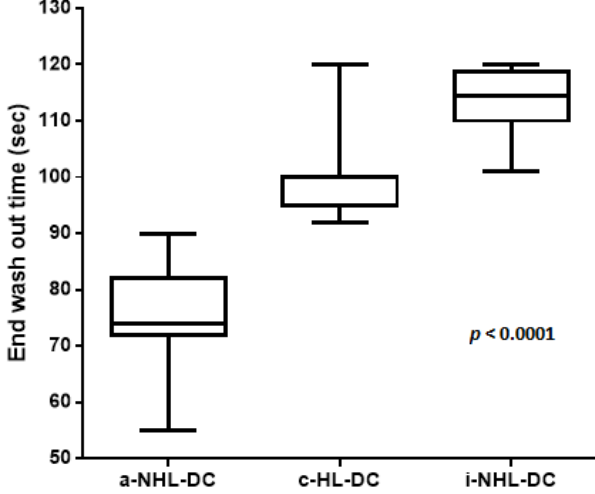
Figure 5. The degree of the contrast intensity of the wash-out of nodules in the three clinical categories of lymphomas. a-NHL-DC, aggressive non-Hodgkin lymphoma diagnostic criteria (122 nodules); c-HL-DC, classic Hodgkin lymphoma diagnostic criteria (60 nodules); i-NHL-DC, indolent non-Hodgkin lymphoma diagnostic criteria (12 nodules).